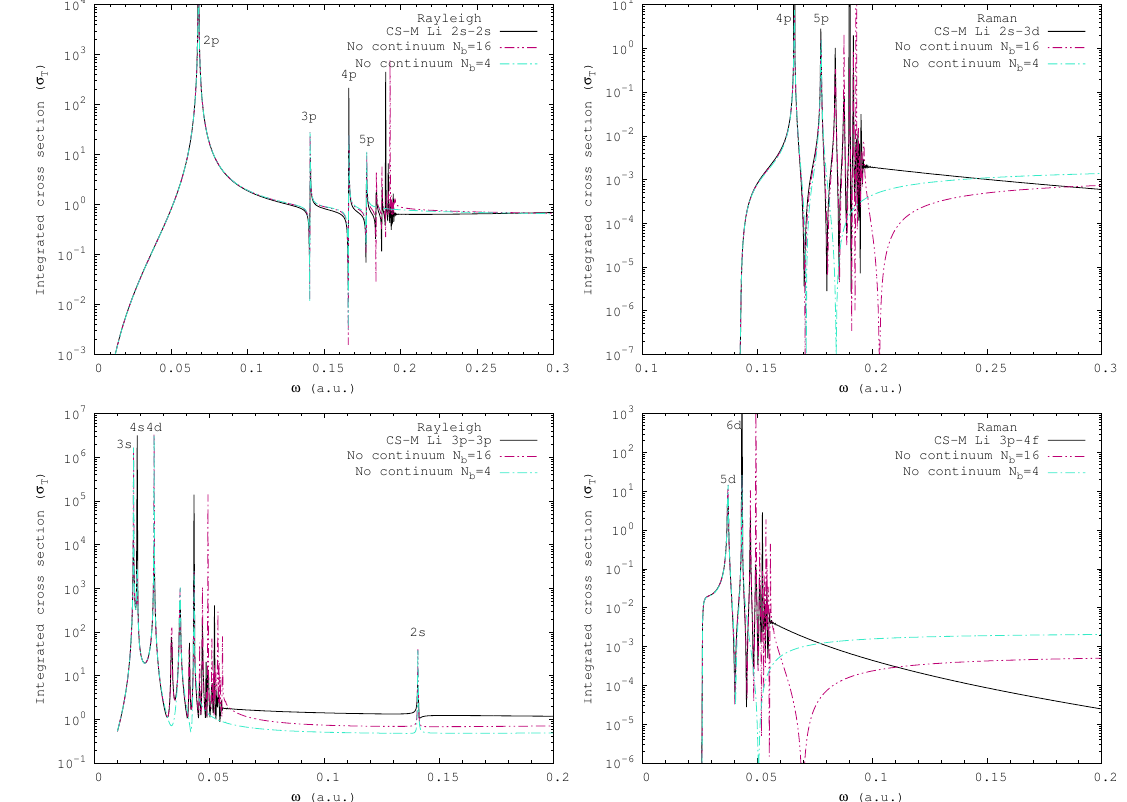
Figure 4. Rayleigh and Raman cross sections for scattering on lithium with increasing number of bound intermediate states and accounting for the target continuum. Cross sections were calculated using the modified length form of the dipole operator and the spin-orbit interaction was neglected. N b indicates the number of included intermediate bound